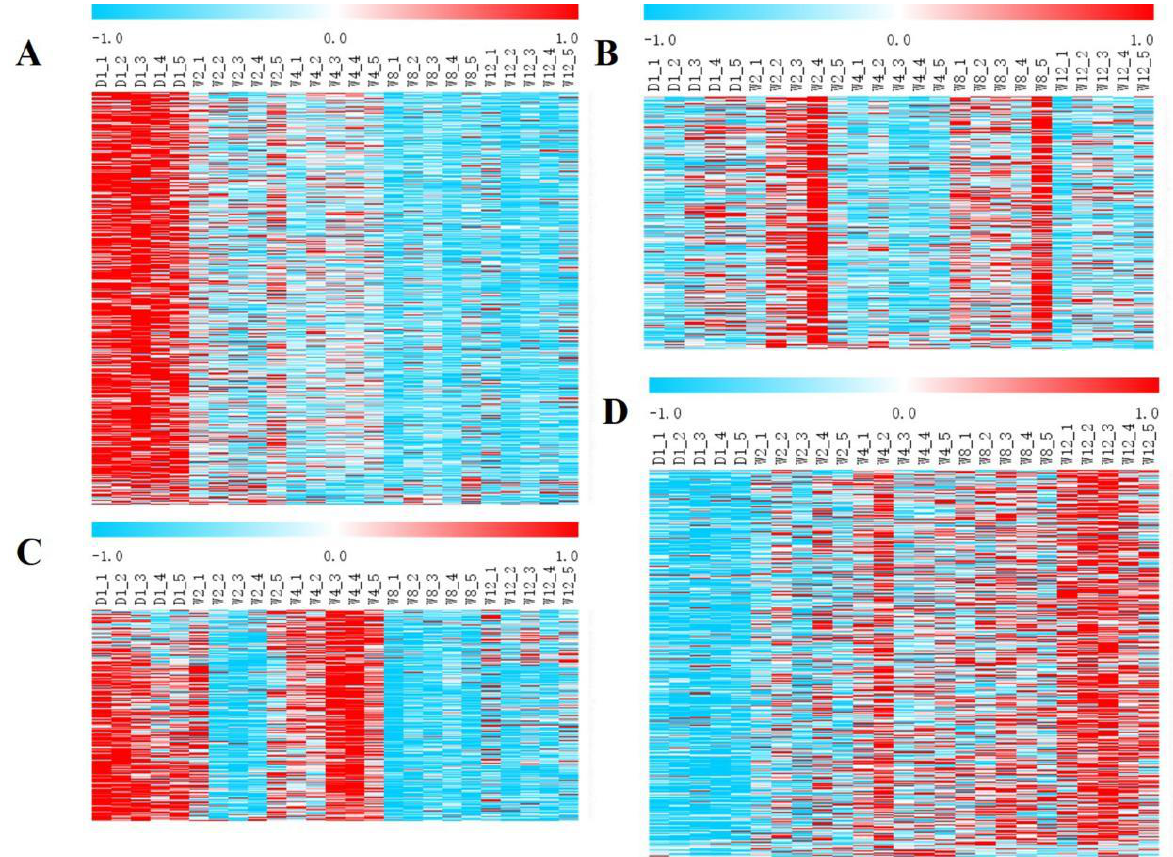
Figure 1. Clustering pattern of DEGs between different groups. ( A ) Cluster 1 of DEGs between different groups. The DEGs expression levels decreased with age in Laiwu black goats. ( B ) Cluster 2 of DEGs between different groups. A high expression of DEGs in the W2 and W8 groups and a low expression in the other groups. ( C ) Cluster 3 of DEGs between different groups. A high expression of DEGs in the D1 and W4 groups and an upregulation of the low expression in the other groups. ( D ) Cluster 4 of DEGs between different groups. The DEGs expression levels increased with age.